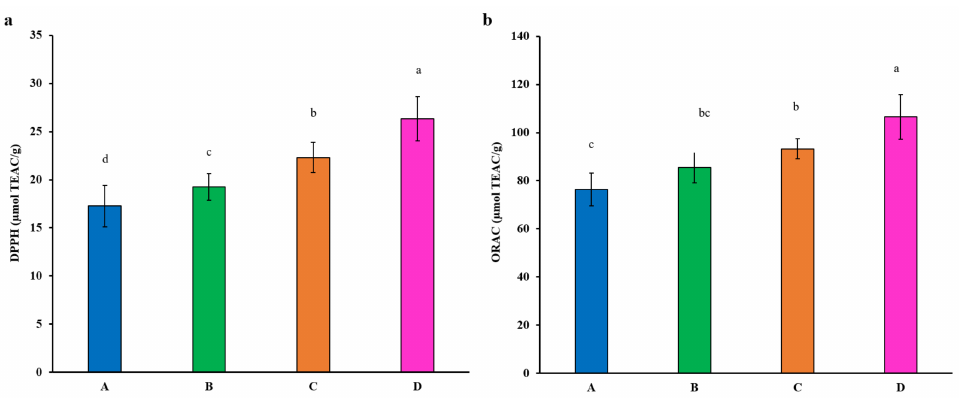
Figure 6. Antioxidant capacity of rice protein samples, ( a ) DPPH, and ( b ) ORAC assays. Lowercase letters in the same column indicate significant differences according to Duncan’s multiple range tests ( p <